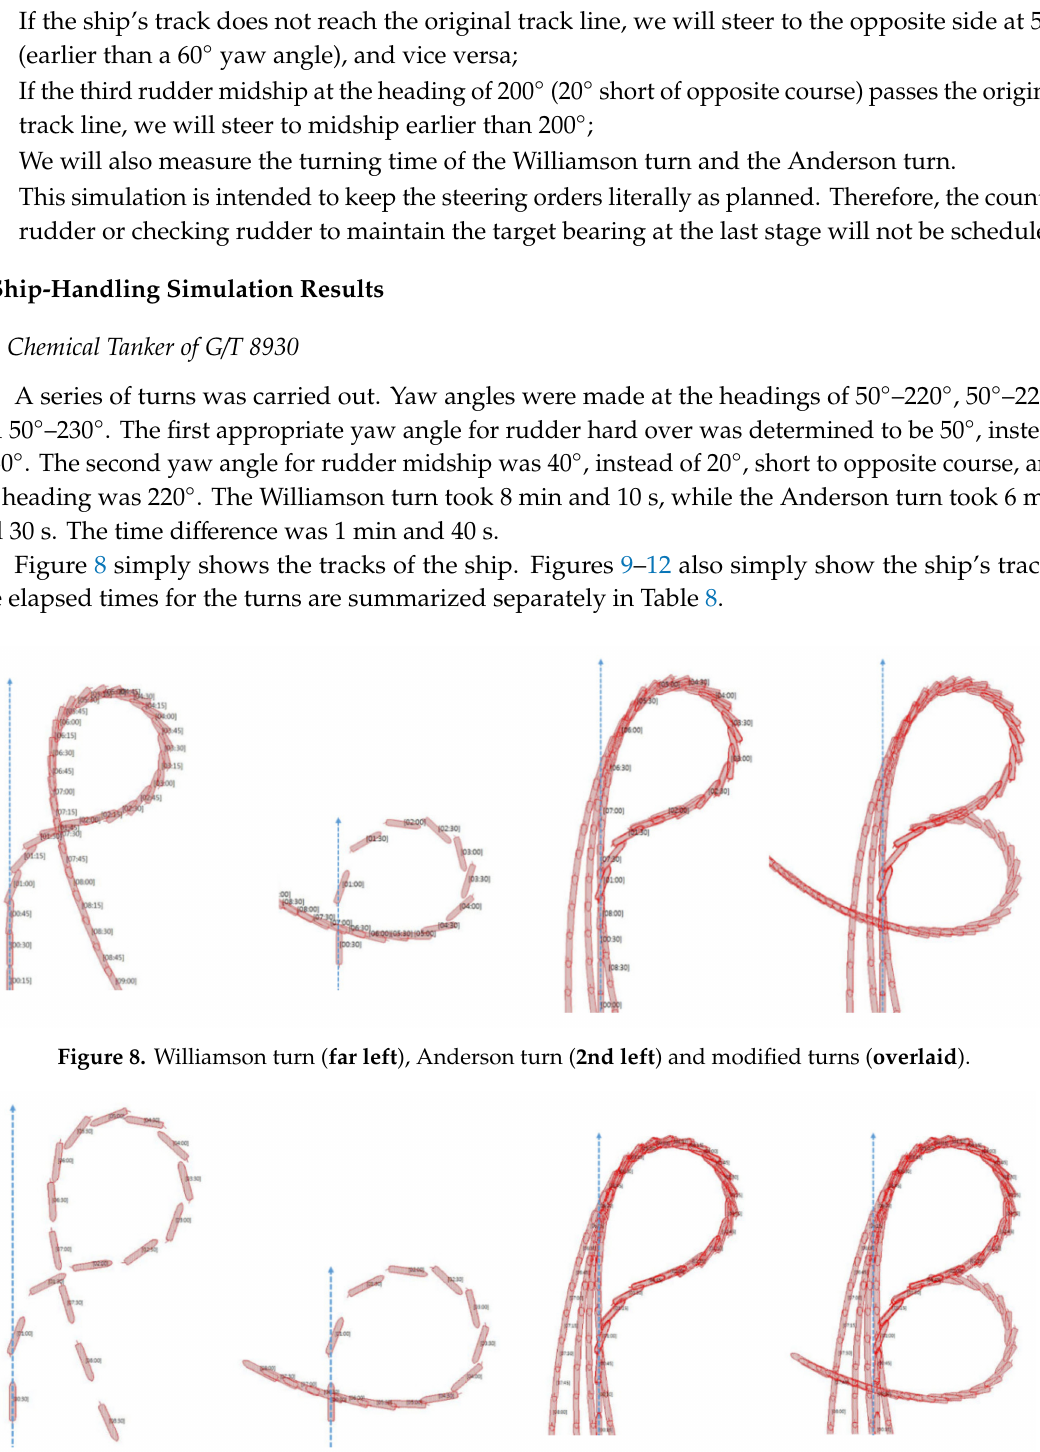
Figure 9. Williamson turn ( far left ), Anderson turn ( 2nd left ) and modified turns ( overlaid